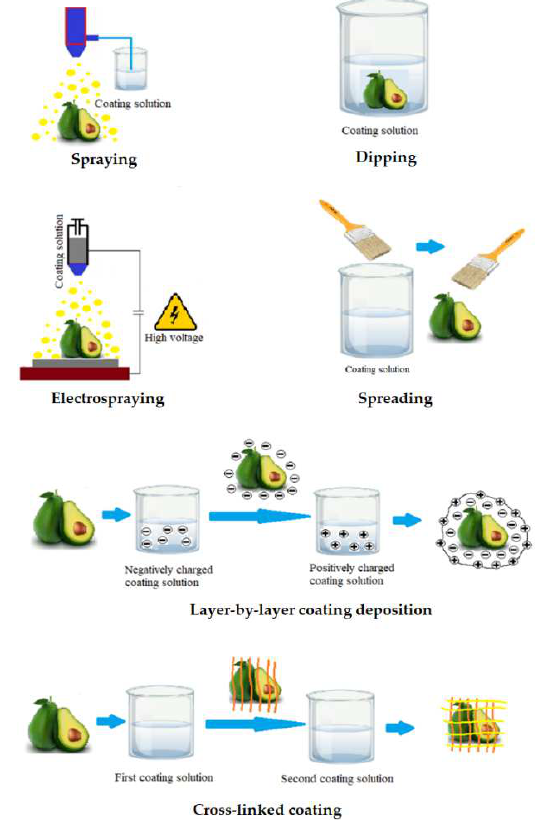
Figure 3. Application methods of edible coating.